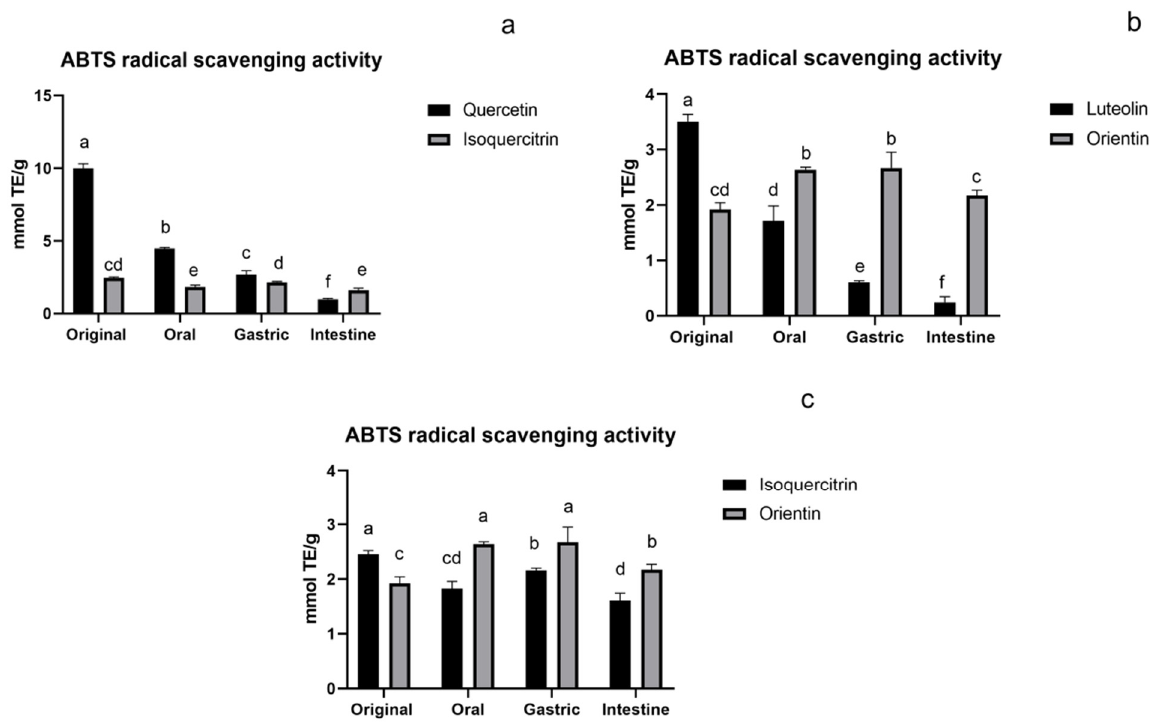
Figure 3. ABTS assay of flavonoids: ( a ) flavonoid O-glycoside and its aglycone, ( b ) flavonoid C-glycoside and its aglycone, and ( c ) flavonoid O-glycoside and flavonoid C-glycoside. The results are reported as means ± SD. Different letters in the figure indicate significant differences ( p < 0.05).